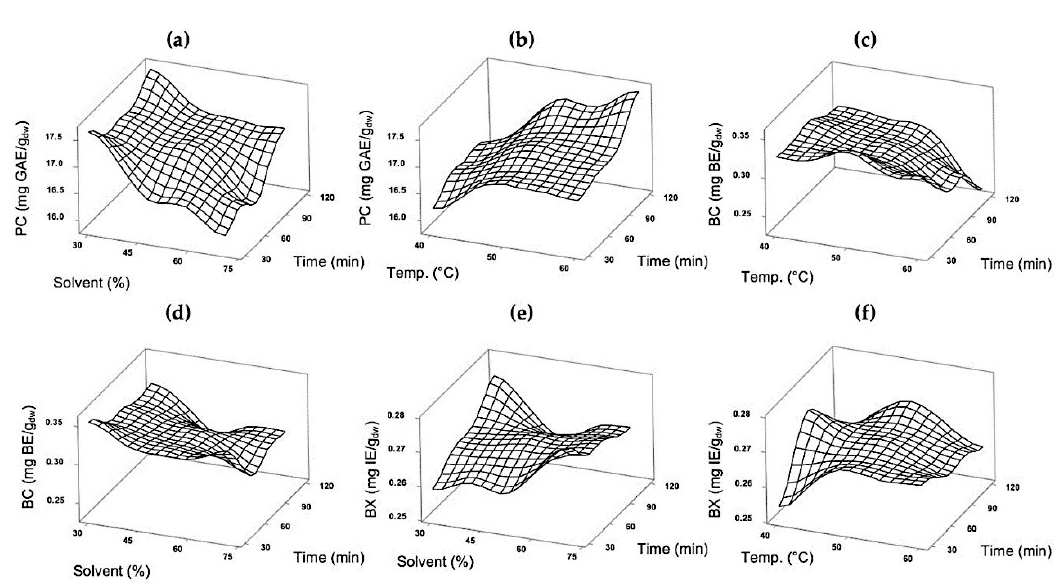
Figure 1. 3D response surface plots showing the effect of process variables on the extraction of PC ( a , b ), BC ( c , d ), and BX ( e , f ). (PC: phenolic compounds; BC: betacyanins; BX: betaxanthins; Temp.: Temperature )